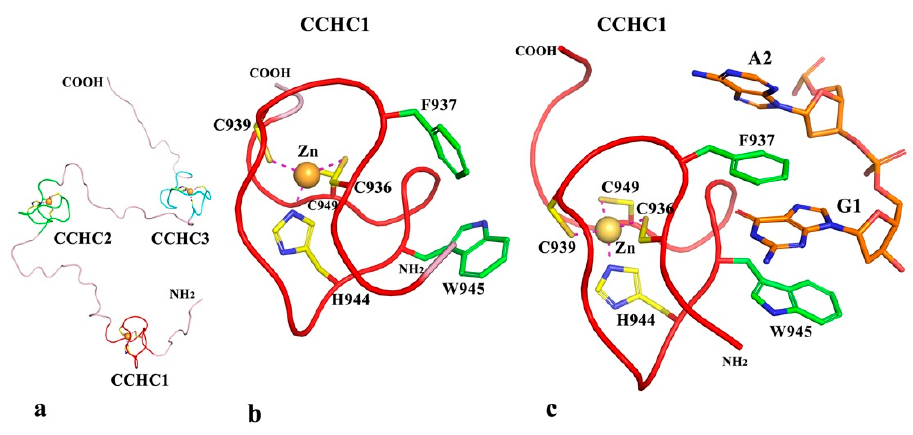
Figure 7. Predicted structures of zf-CCHC repeats in the C-terminal region of P. graminis f. sp. tritici topoisomerase III. ( a ) Predicted structures for the three zf-CCHC domains (CCHC1, CCHC2, and CCHC3) connected by flexible linkers. ( b ) A ribbon diagram of CCHC1. Besides the three cysteines and one histidine that form the Zn 2+ -binding site, two key residues (F937 and W945) that may contribute to DNA-binding are drawn in stick format. ( c ) A DNA-binding model of CCHC1 with a dinucleotide (GA).